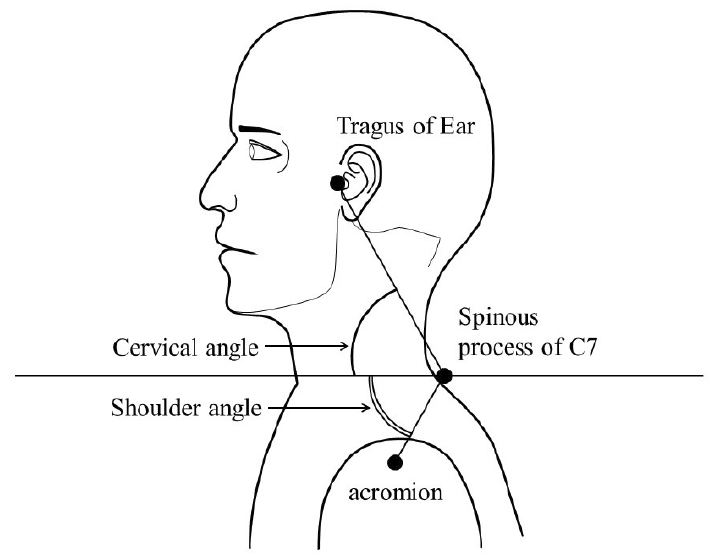
Figure 1A.. Cervical and shoulder angles. Figure A1. Cervical and shoulder